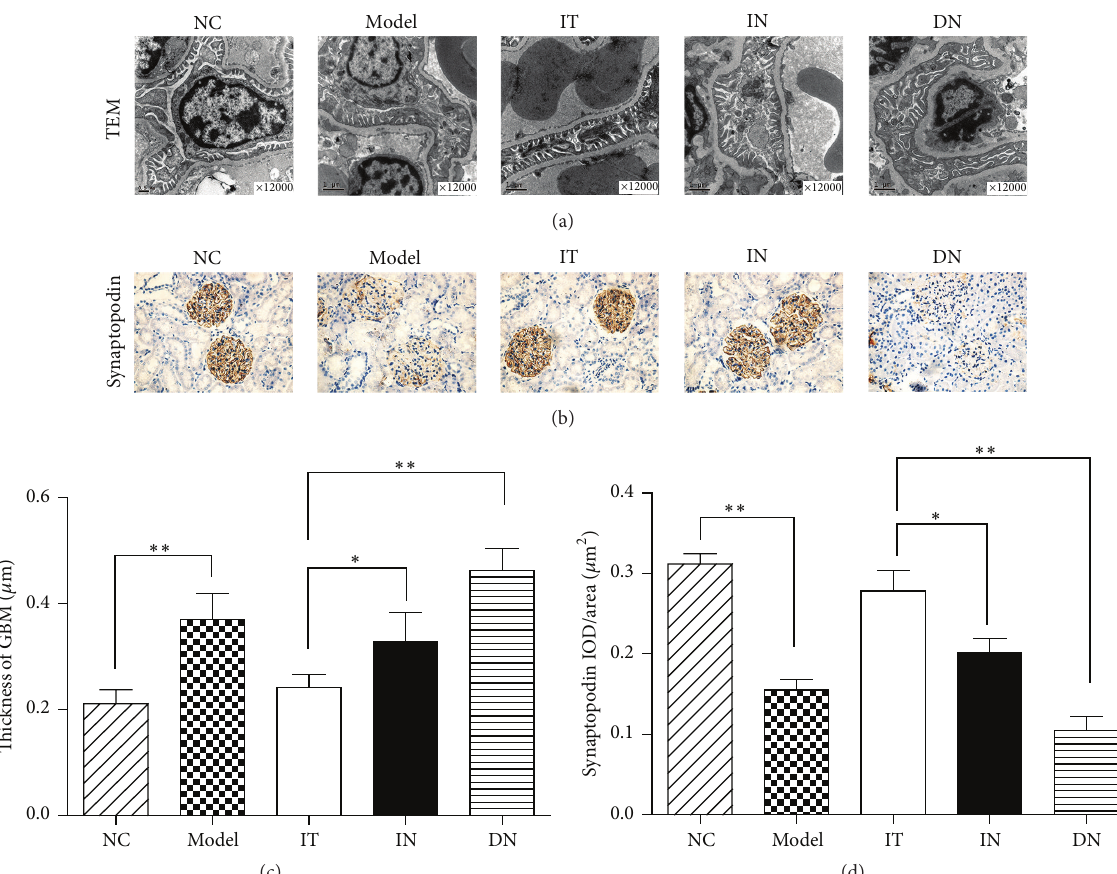
Figure 3: TEM detection of renal tissues and immunohistochemical staining for synaptopodin in podocytes. (a) TEM detection of podocytes and the glomerular filtration barrier. (b) Immunohistochemical staining for synaptopodin, which stains podocytes specifically, to measure the density of podocytes. (c) Measurement of the thickness of the GBM in each group, ∗ 𝑝 = 0.012 and ∗∗ 𝑝 < 0.001 . (d) Comparison of the IOD/area of synaptopodin immunohistochemical staining for each group, ∗ 𝑝 = 0.003 and ∗∗ 𝑝 < 0.001 . IOD/area, integrated optical density/area. The mean of IOD/area of positive staining was used to accurately measure the degree of positive expression in immunohistochemical staining. Model group: diabetic nephropathy model rats established at 12